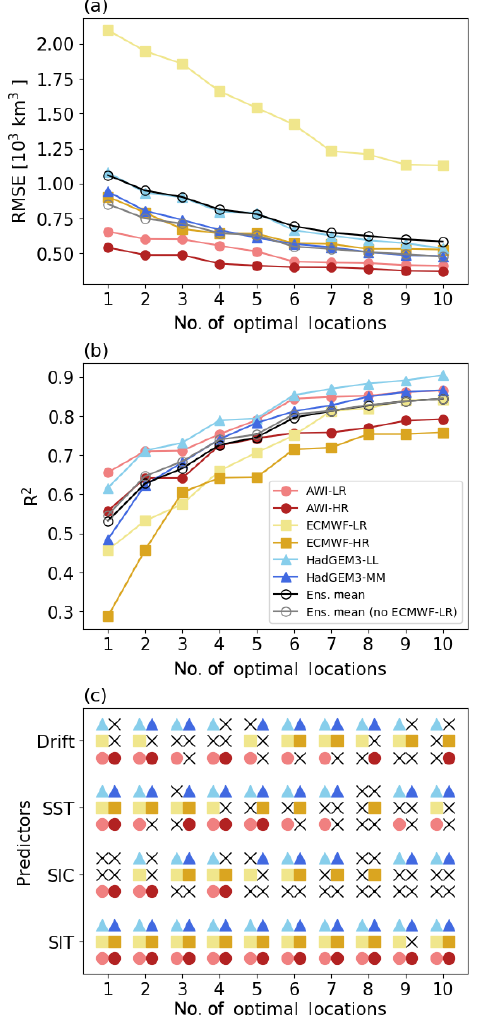
Figure 11. (a) RMSE ( y axis) estimated between the original and reconstructed time series by taking into account predictor variables from one up to 10 optimally selected locations ( x axis). (b) Same as (a) but using R 2 ( y axis) to compare original and reconstructed time series. (c) Valid predictors, as determined by the correlation maps, retrieved from each targeted location. If a predictor is valid ( y axis), its respective symbol, as defined in the inset legend from (b) , is plotted. A black cross indicates that the predictor is not valid at the respective